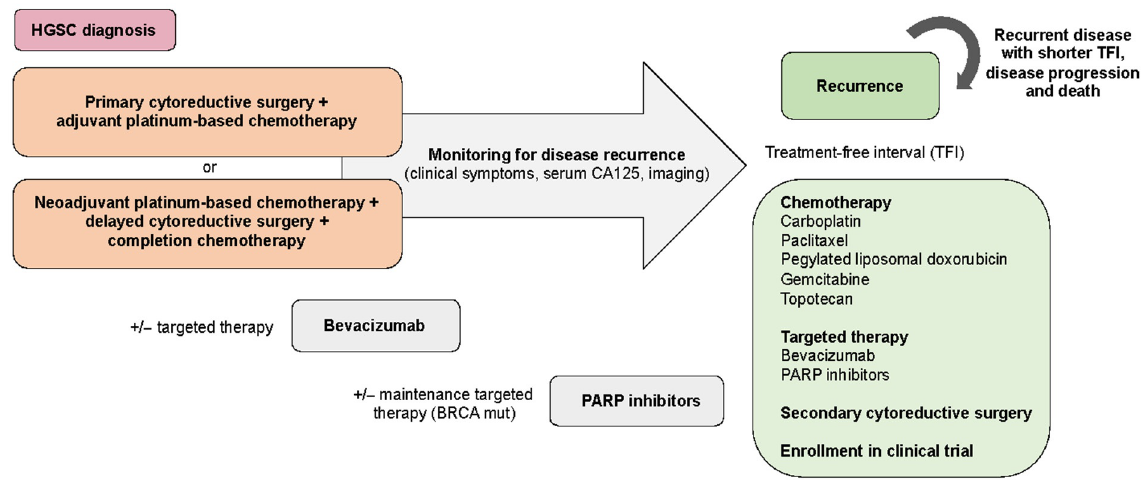
Figure 1. Main characteristics of the different epithelial ovarian carcinoma histological subtypes [3]. Data reflects the most common molecular alterations, stage at diagnosis, and prognosis.